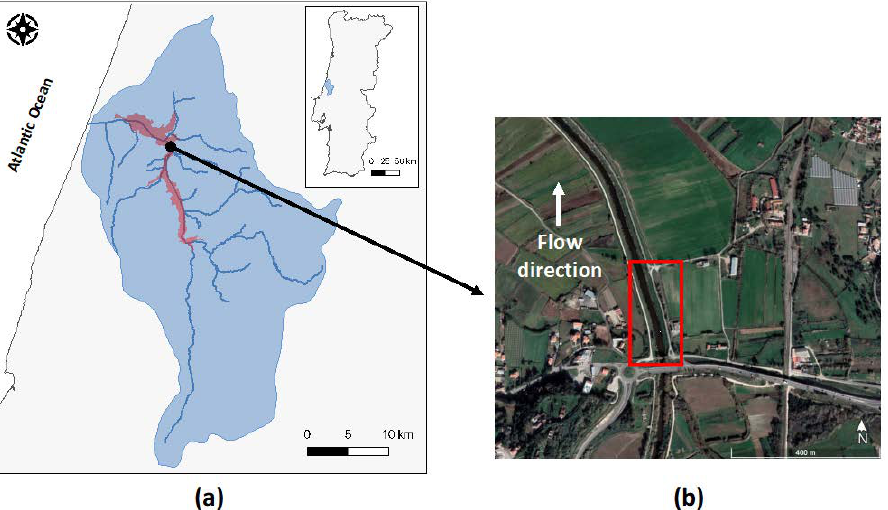
Figure 1. Study area: ( a ) Location of the Lis River basin, in the center of Portugal: the shaded red area identifies the Lis Valley Irrigation District (LVID). ( b ) Zoom in of the study site, focusing on a selected section of the Lis River (adapted from Google Earth 2021).